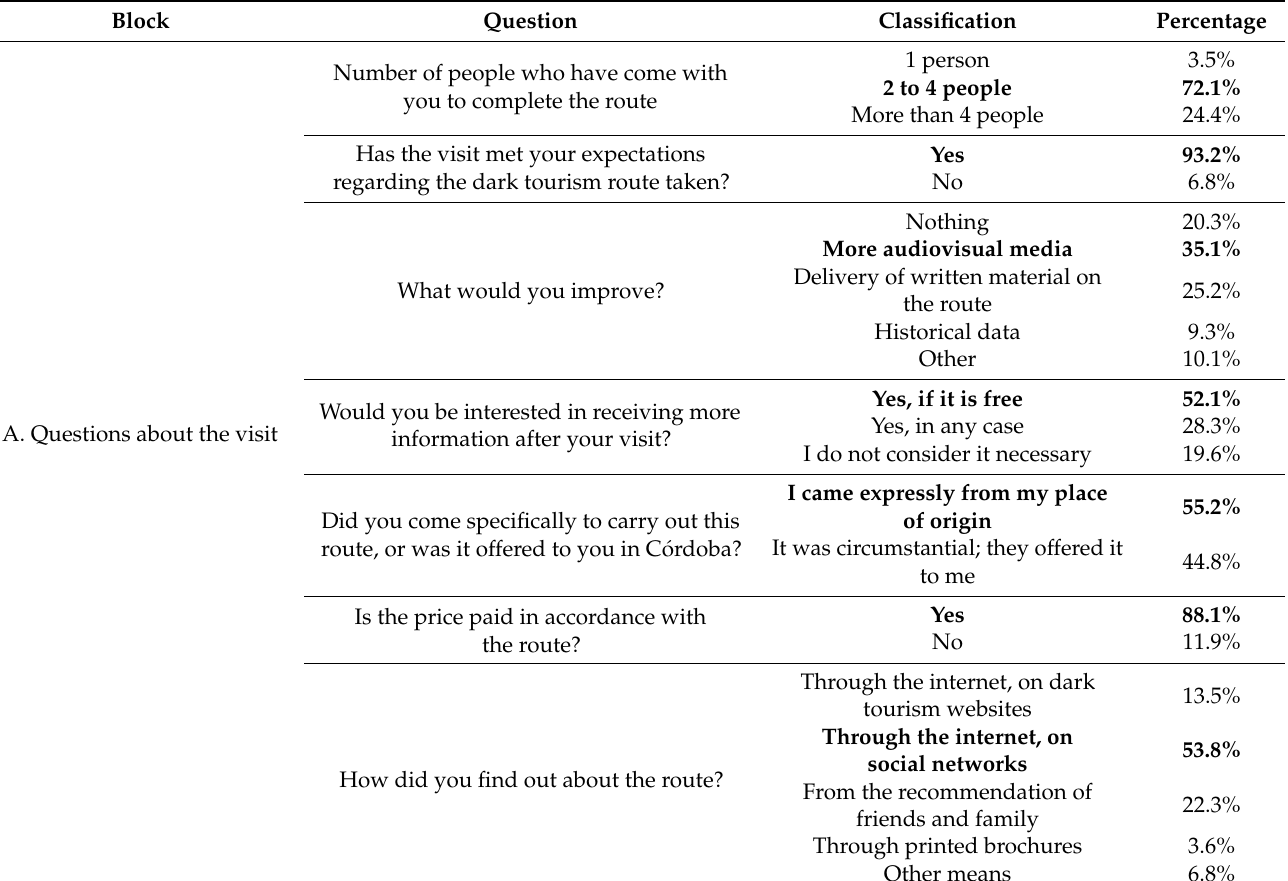
Table 3. Univariate results of the survey of people who participated in dark tourism. in C ó rdoba: Questions about the visit. Block